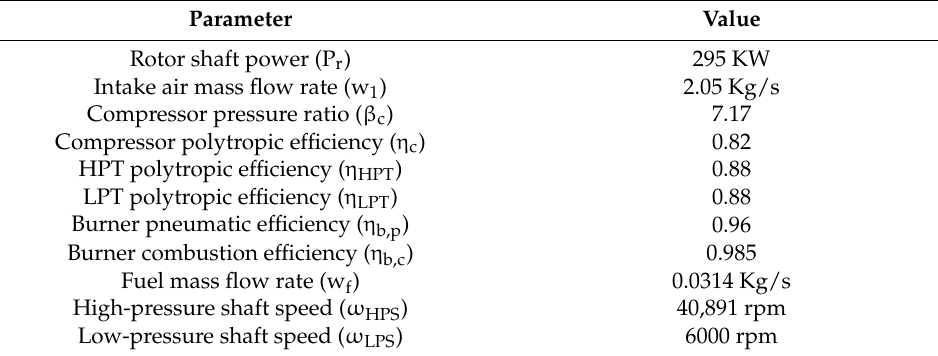
Figure 1. Block model of the used engine. Table 1. Engine parameters in design point.